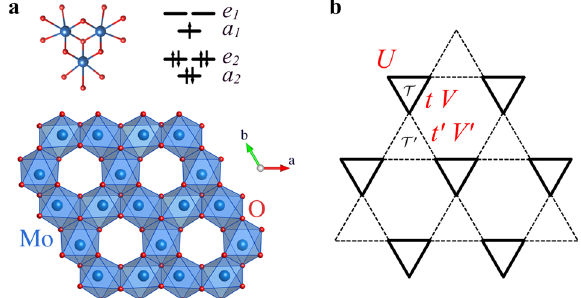
Fig. 1 Extended Hubbard model for the Mo 3 O 8 systems. a Anisotropic kagomé layers formed by the Mo atoms and molecular levels of the Mo 3 O 13 cluster fi lled with seven electrons. b Schematics of the extended Hubbard model on the anisotropic kagomé lattice. Nonequivalent “ up ” and “ down ” triangles are denoted as T 0 and T , respectively.